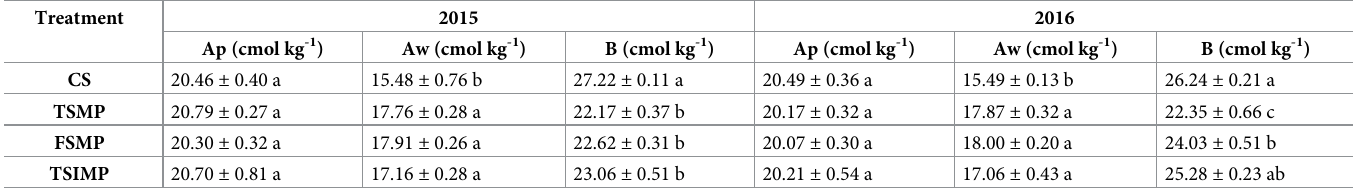
Different lowercase letters indicate significant differences between samples (p < 0.05). Values are means ± standard errors (n =